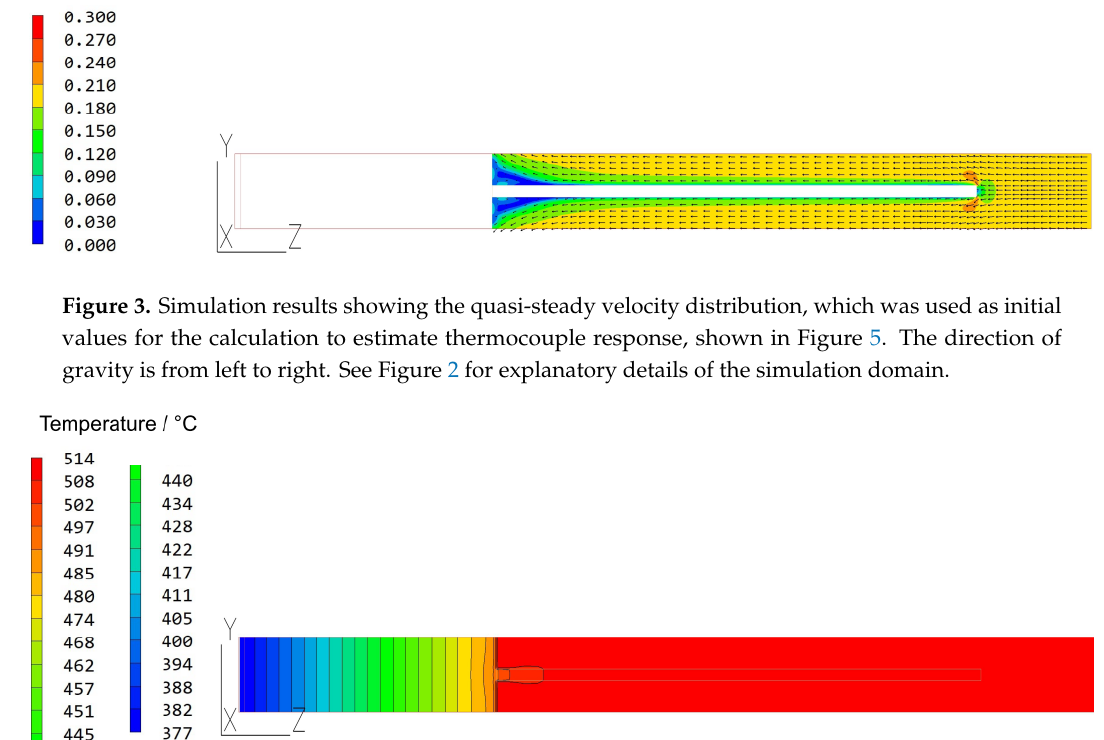
Figure 3. Simulation results showing the quasi-steady velocity distribution, which was used as initial values for the calculation to estimate thermocouple response, shown in Figure 5. The direction of gravity is from left to right. See Figure 2 for explanatory details of the simulation domain.